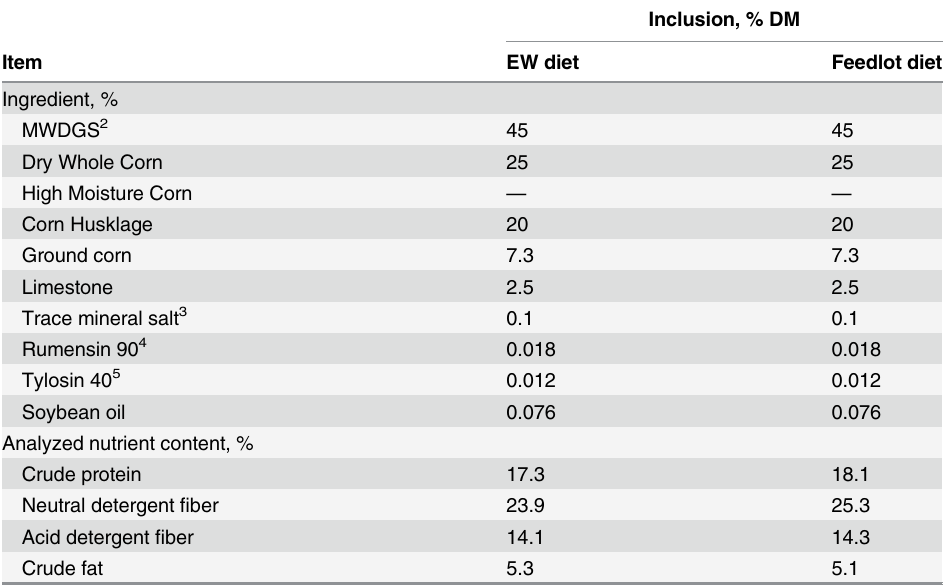
Table 1. Composition of diet (DM basis) fed to early wean (EW) steers upon arrival to feedlot and prior to normal weaning 1 and feedlot diet fed to EW and normal wean (NW) steers after normal weaning. Inclusion, % DM Item EW diet Feedlot